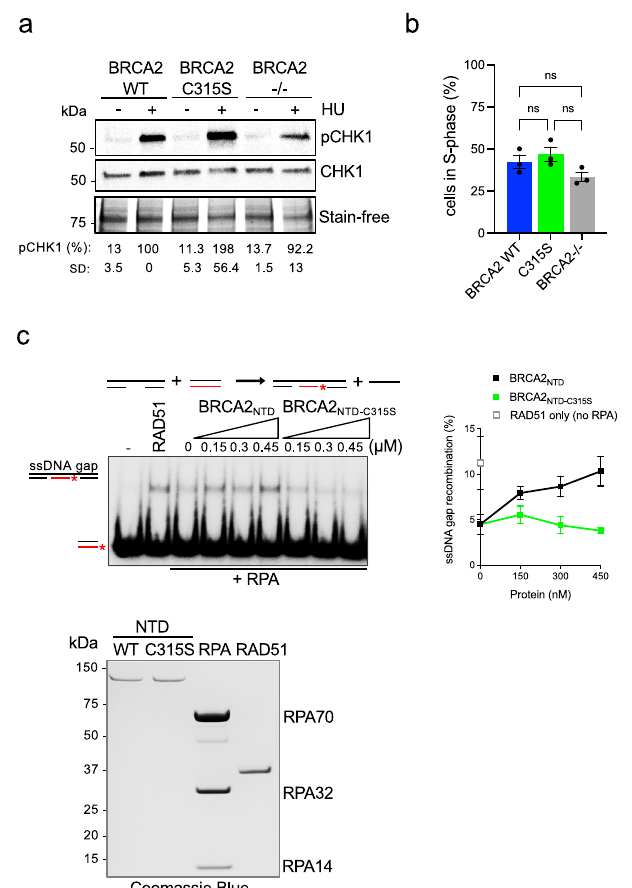
Fig. 6 | BRCA2-C315S cells show an active ATR checkpoint whereas NTD-C315S fragment shows reduced stimulation of RAD51-mediated ssDNA gap repair. a (Left)WesternblotshowingthephosphorylationofCHK1(pCHK1)afterexposure to HU (0.5mM, 2h) as indicated in DLD1 BRCA2-de fi cient cells (BRCA2 − / − ) or BRCA2 − / − cells stably expressing BRCA2 WT or the variant BRCA2-C315S. Stain-free cropped gel is used as the loading control. pCHK1 levels relative to the total CHK1 signal are shown below the blots, results are presented as a percentage of pCHK1/CHK1 compared to the BRCA2 WT clone treated with HU. The data repre- sent the mean±SD of two independent experiments . b Frequency of S-phase cells inDLD1BRCA2-de fi cientcells(BRCA2 − / − )orBRCA2 − / − cellsstablyexpressingBRCA2 WT or the variant BRCA2-C315S. The data represent the mean±SEM of three independent experiments. Statistical difference was determined by the Kruskal – Wallis test followed by Dunn ’ s multiple comparison test (ns, not sig- ni fi cant). See also Supplementary Fig. 6. c (Left) DNA strand exchange reaction using an ssDNA gap mimicking substrate (Table S1) in the presence or absence of RPA, RAD51, and increasing concentrations of BRCA2 NTD-WT or BRCA2 NTD-C315S , as indicated. (Right) Quanti fi cation of the reaction on the left. Data represent the mean from three independent experiments. Error bars SD. (Bottom) SDS – PAGE showing puri fi ed BRCA2 NTD-WT (1 µ g), BRCA2 NTD-C315S (1 µ g), RPA (3 µ g), and RAD51 (1.5 µ g) used in the DNA strand exchange reactions. Source data are provided as a Source Data fi